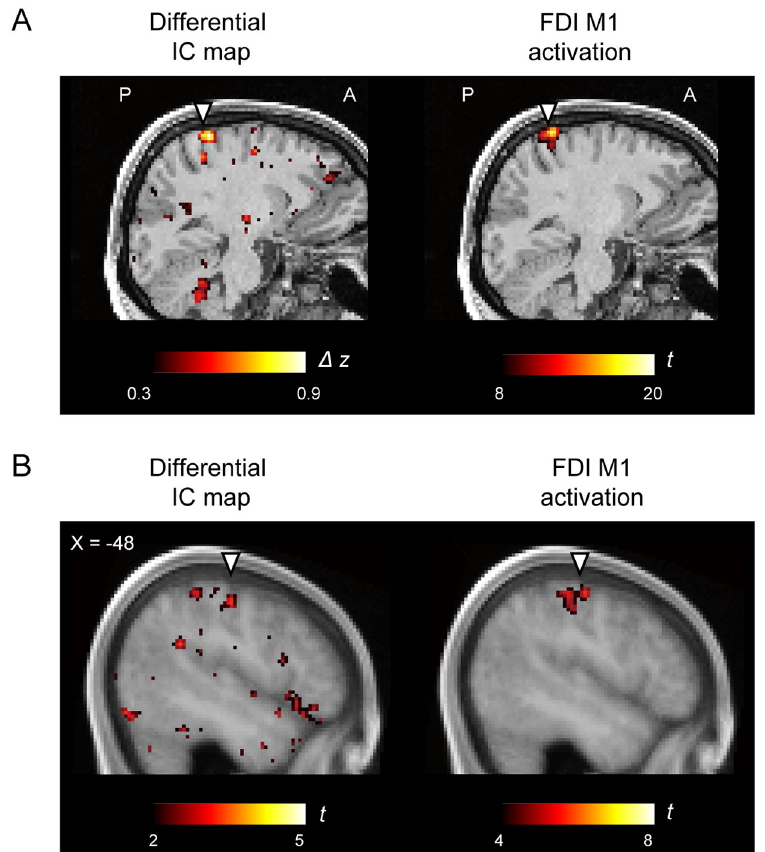
Fig 7. Comparison of differential interhemispheric connectivity and brain activity during finger movement. (A) The differential interhemispheric connectivity map (left) and brain activation map (right) in one representative subject (the same as Figs 4 and 5) in the original subject space. Triangles indicate the central sulcus of the subject. The color scale represents the differential Fisher’s z value (left) or t-value (right). (B) Group results of the two maps in MNI space. Triangles indicate the central